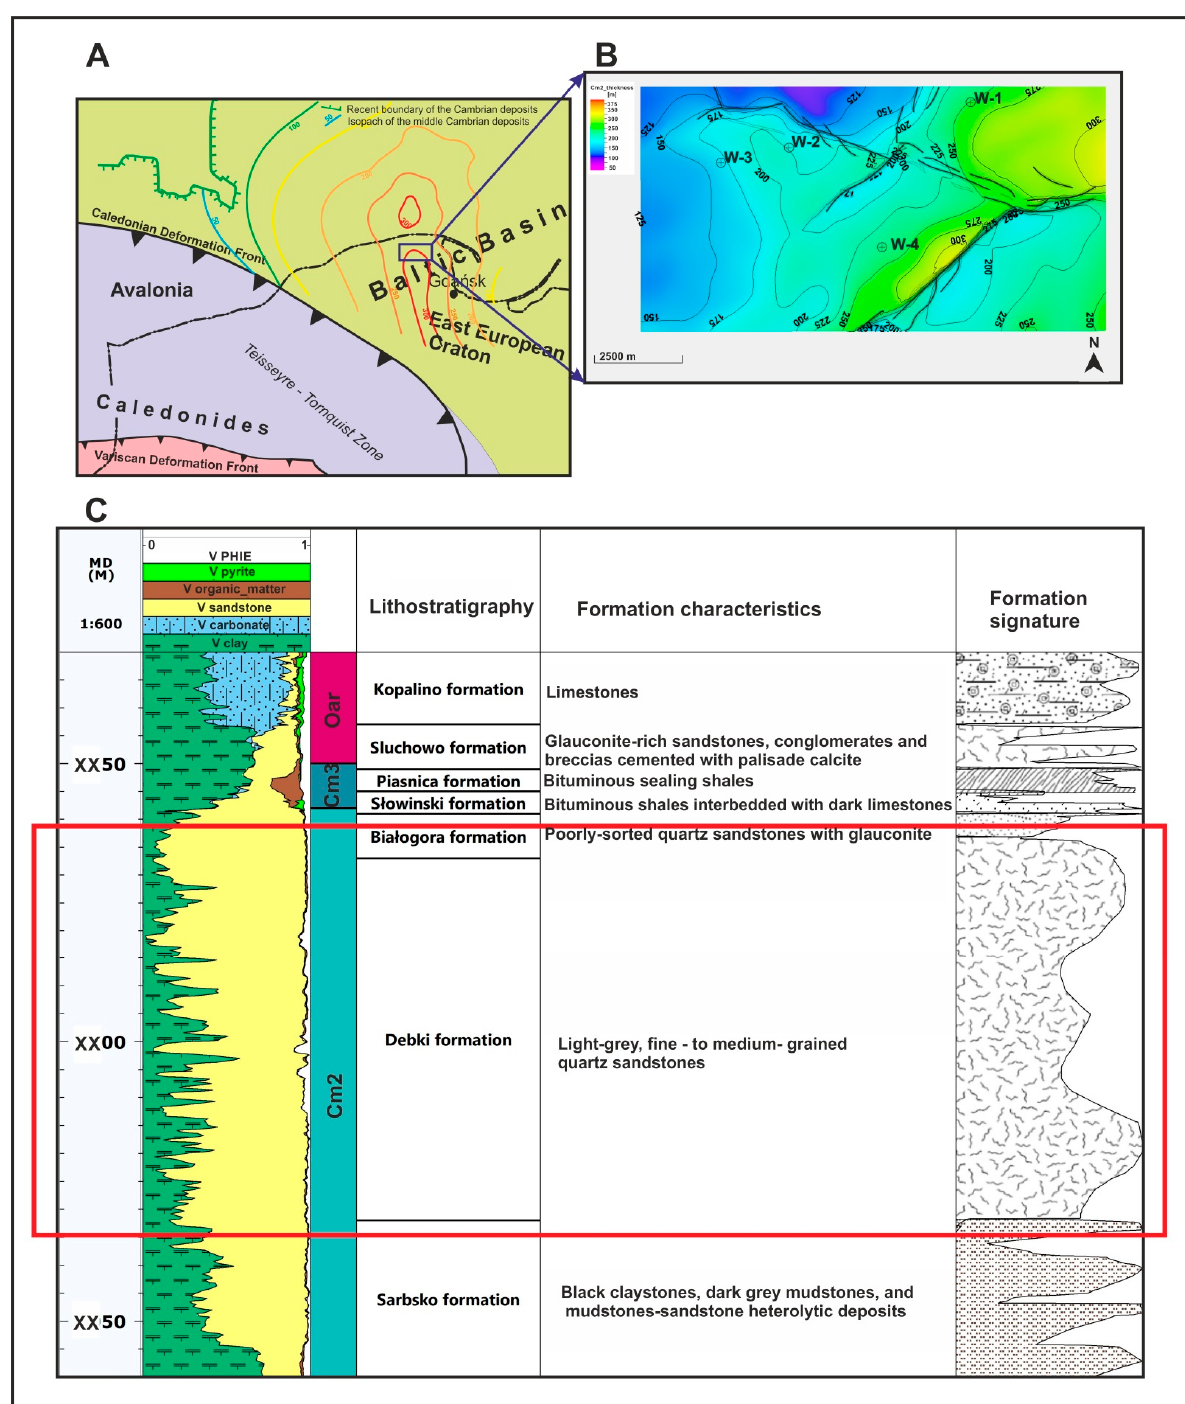
Figure 1. Location of the study area on a background paleothickness map of Middle Cambrian deposits (changed after 12; [25]) ( A ), detailed thickness map constructed for the investigated Middle Cambrian deposits with the arrangement of occurring fault system marked with black lines and the location of analyzed boreholes W-1-4 ( B ), and the exemplary lithostratigraphic profile including Arenig (Oar), Upper Cambrian (Cm3) and Middle Cambrian sediments (Cm2) in borehole W-3 with the lithostratigraphical units description after 12 ( C